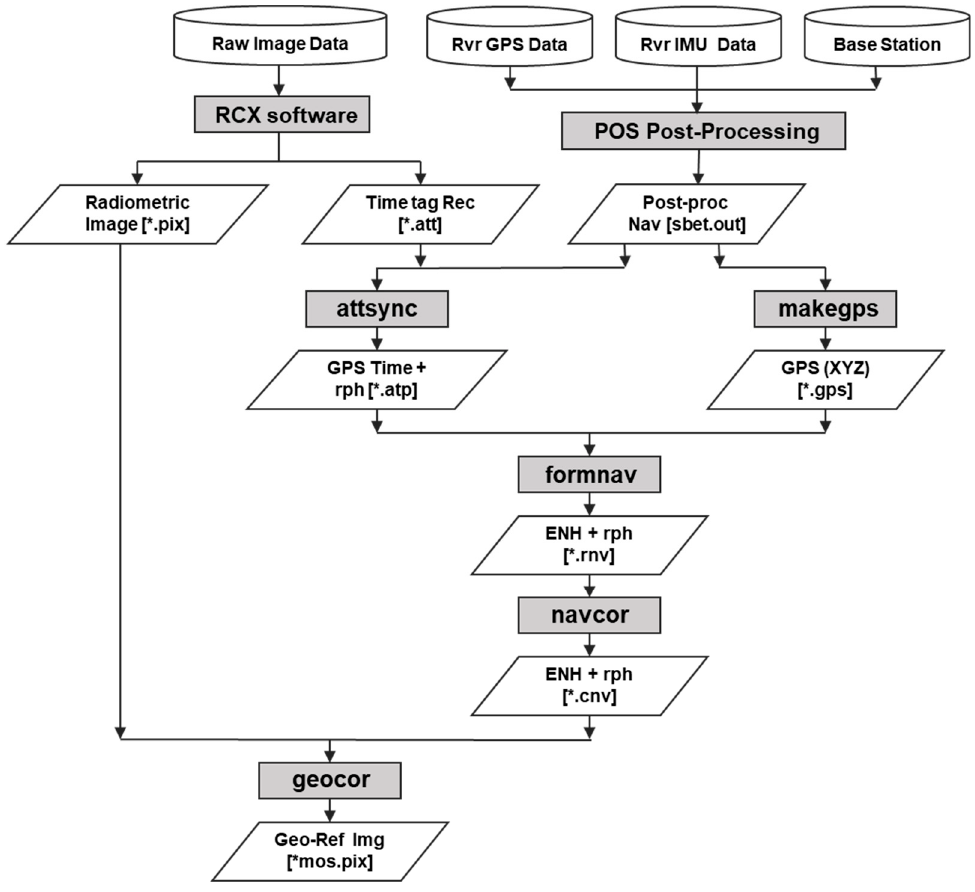
Figure 3. The diagram of ITRES’s standard processing including radiometric and geometric correction [50].